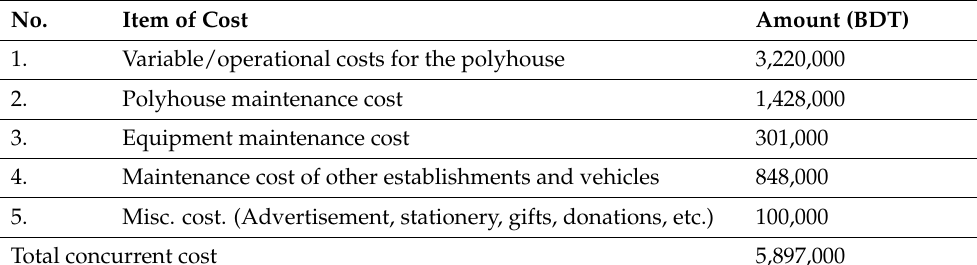
Table 2. Concurrent costs needed from the second